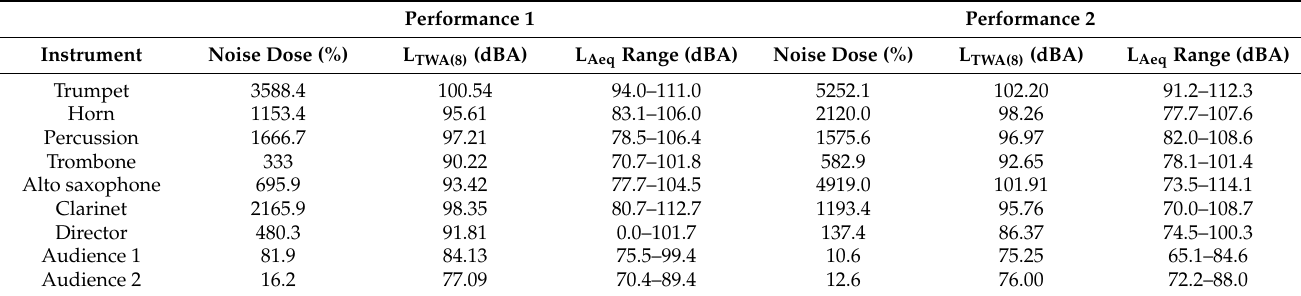
Table 2. Summarized data for noise dose, L Aeq range, and L TWA(8) of 6 marching band members, director and non-marching band students during